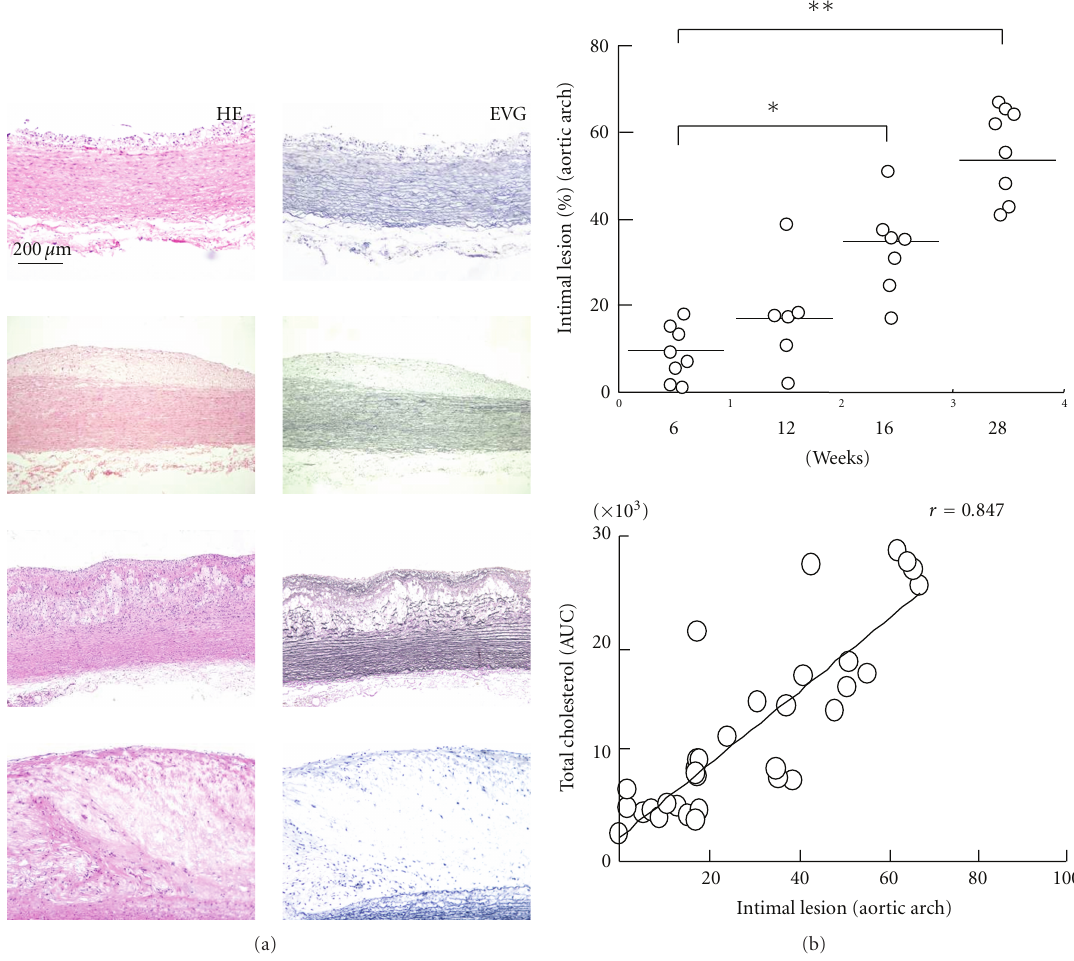
Figure 3: Microscopically atherosclerotic lesions. Representative images of aortic atherosclerosis as stained with H&E and EVG (a). The intima lesional areas (upper) in the sections were measured using the EVG sections and the correlations (beneath) between cholesterol exposure and intima lesions area (b). The data are expressed as the means ± SEM. n = 6–8 for each group. ∗ P < 0 . 05 and ∗∗ P < 0 .